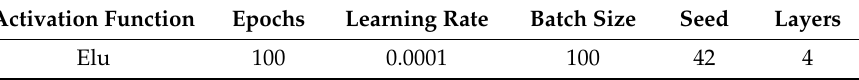
Table 7. DNN parameters for